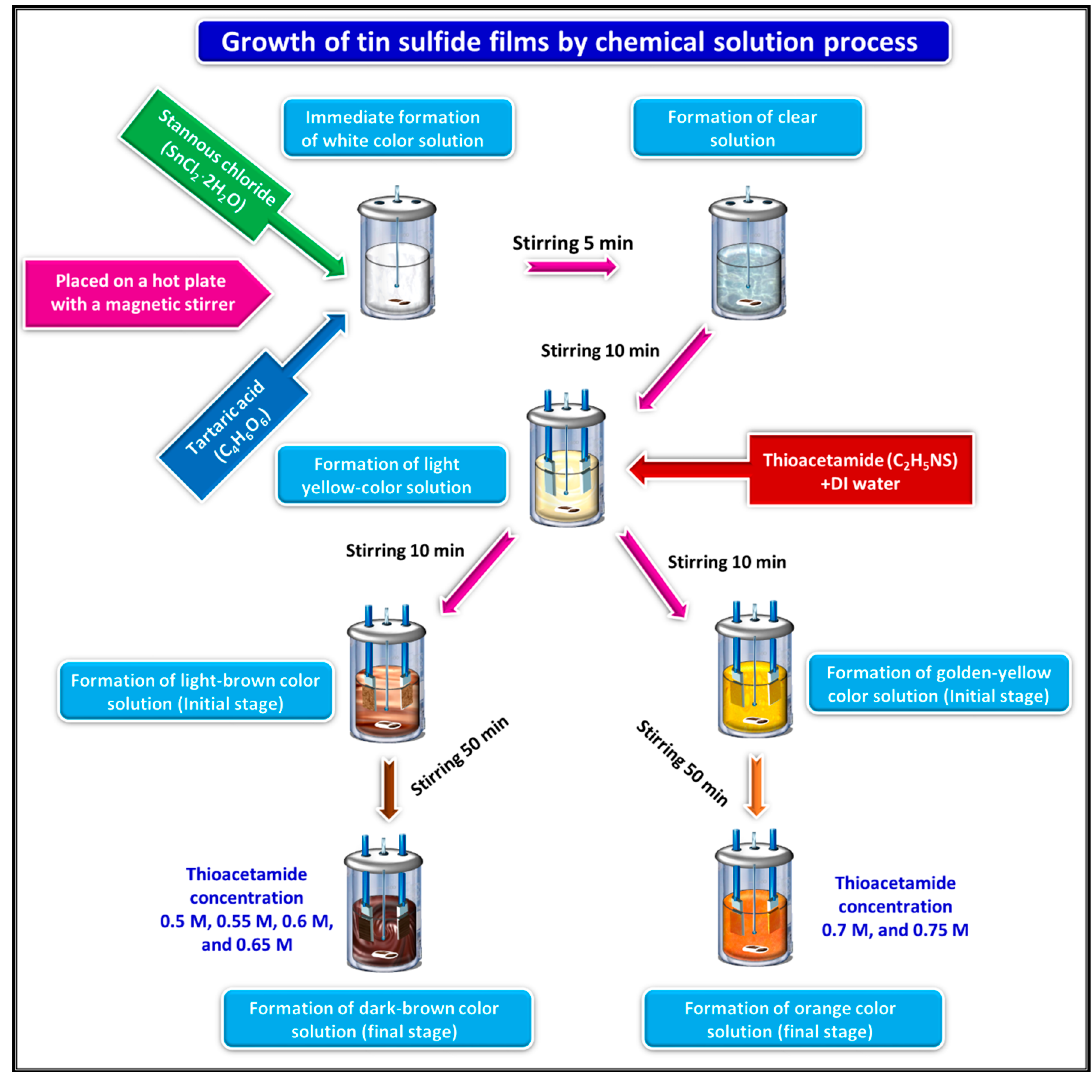
Figure 2. Schematic representation of the growth of tin sulfide films. 96